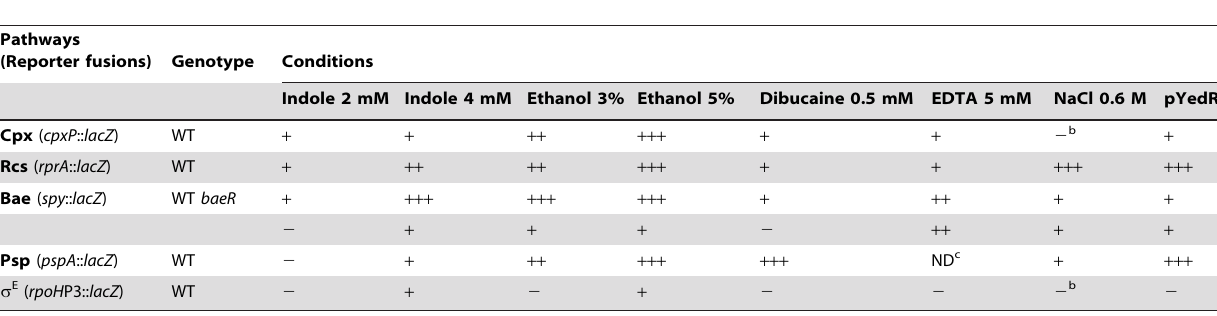
Table 1. Induction of extracytoplasmic stress response pathways in response to various stimuli a . Pathways (Reporter fusions)